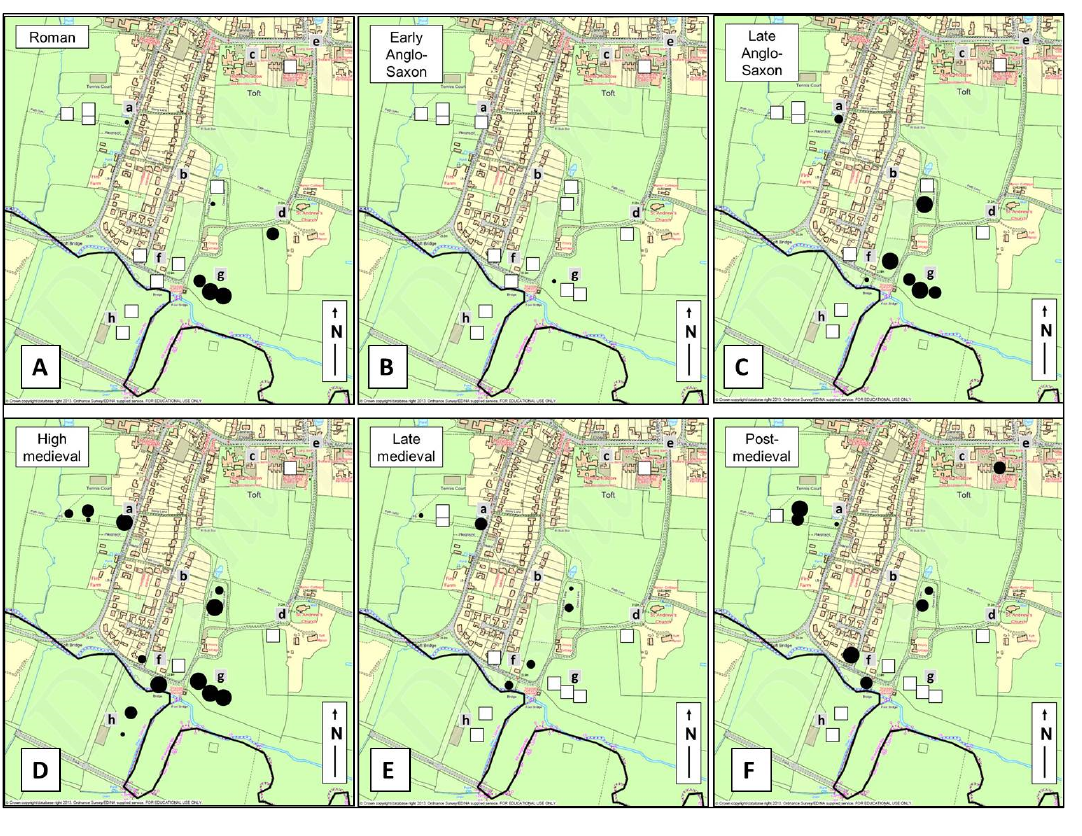
Figure 4. Pottery from test pits excavated in Toft. (A) Roman; (B) Early Anglo-Saxon; (C) Late Anglo-Saxon; (D) High medieval; (E) Late medieval; and (F)